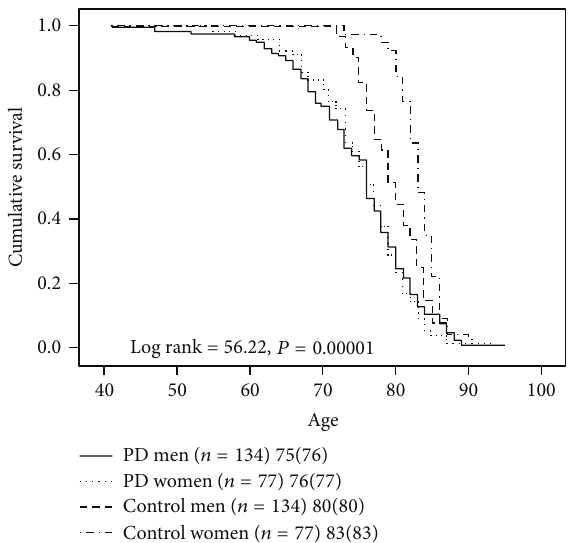
Figure2:SurvivalanalysisofPDmenandPDwomenversuscontrol men and control women from the U.S. population. PD men and PD women have no difference in survival, while both PD men and PD women have reduced survival relative to control men and control women, respectively.